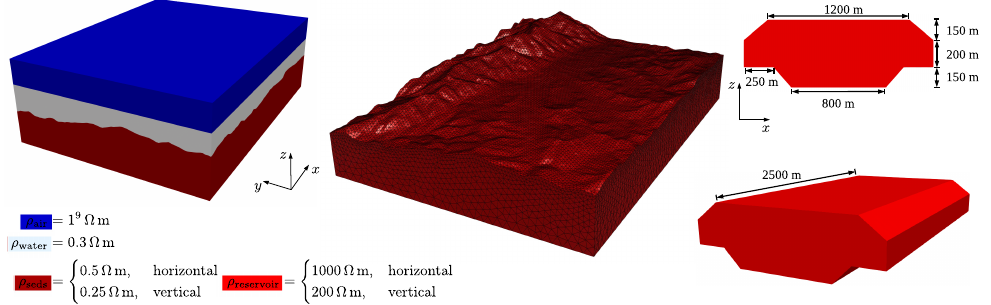
Figure 3. Synthetic 3D VTI marine model with bathymetry. A 3D view of the complex seabed and the reservoir unit are provided. The resistivity values for each material are also